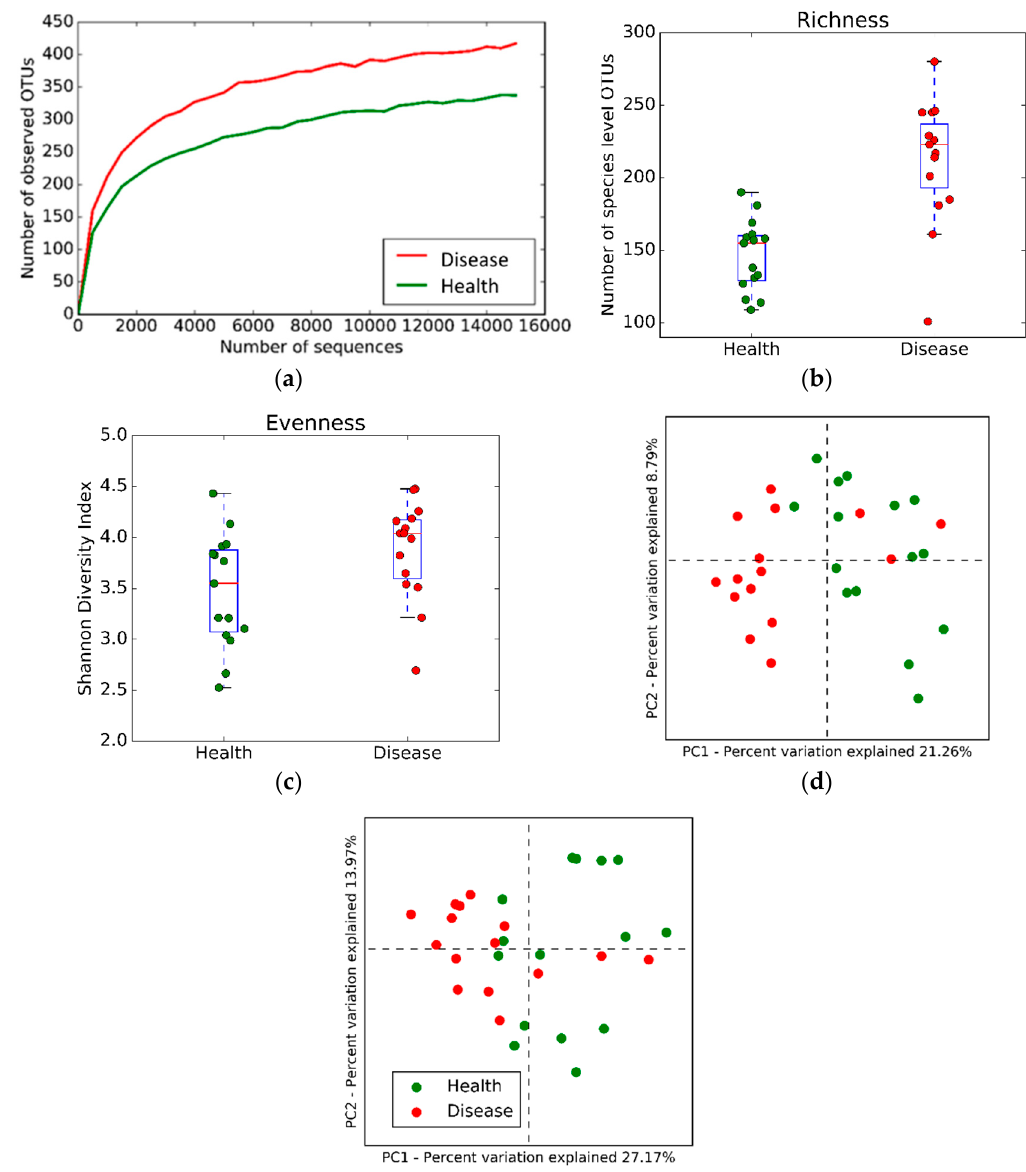
Figure 2. Alpha-diversity and beta-diversity analyses. Alpha-diversity analysis shown in Panels a–c; Beta-diversity in Panels D and E. The rarefaction curve (Panel A) shows a greater number of operational taxonomic units (OTUs) are observed in women with, compared to without periodontal disease. Species richness (Panel B) was greater in women with, than without periodontal disease. No difference in species evenness (Panel C) was observed. ( a ) Panel A. Rarefaction curve; ( b ) Panel B. Species richness plot; ( c ) Panel C. Species evenness plot; ( d ) Panel D. Unweighted UniFrac distance; ( e ) Panel E. Weighted UniFrac distance.